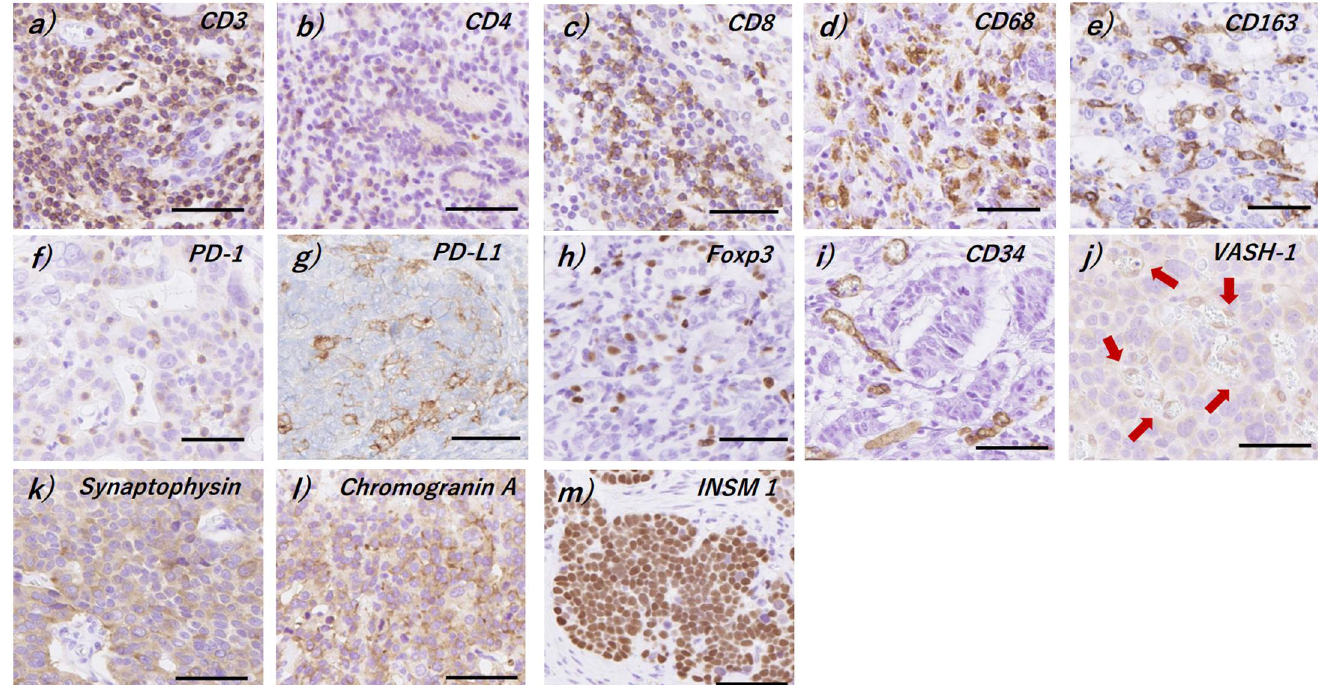
Figure 1. Representative illustration of immunohistochemical staining. ( a ) CD3, ( b ) CD4, ( c ) CD8, ( d ) CD68, ( e ) CD163, ( f ) PD-1, ( g ) PD-L1, ( h ) Foxp3, ( i ) CD34, ( j ) vasohibin-1 (VASH-1), ( k ) synap- tophysin, ( l ) chromogranin A, and ( m ) insulinoma-associated 1 (INSM1). Arrows: VASH-1-positive micro-vessels. Bars: 50 μm.